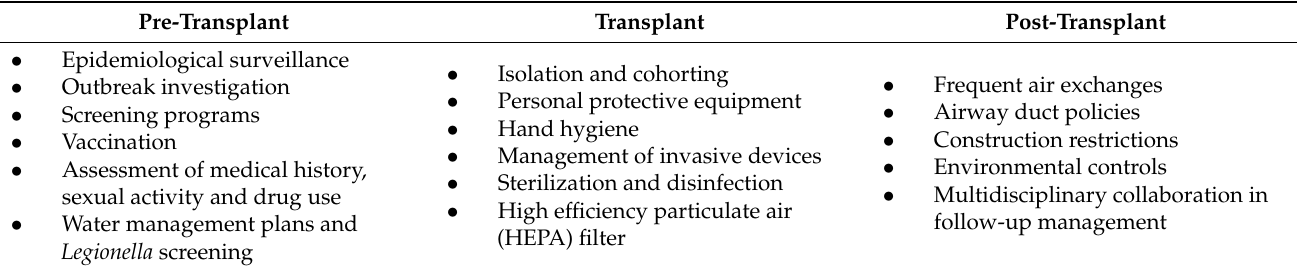
Table 1. Risk assessment in solid organ transplant